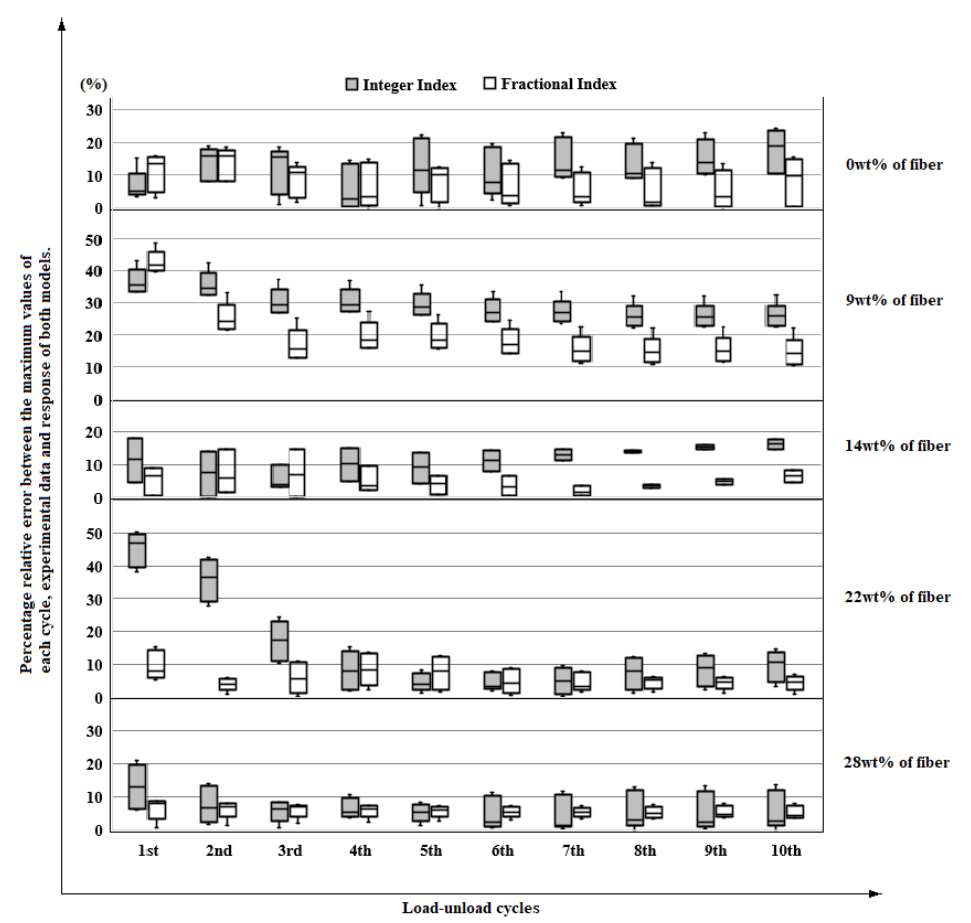
Figure 10. Percentage relative error between the maximum values of each cycle, experimental data and response of both